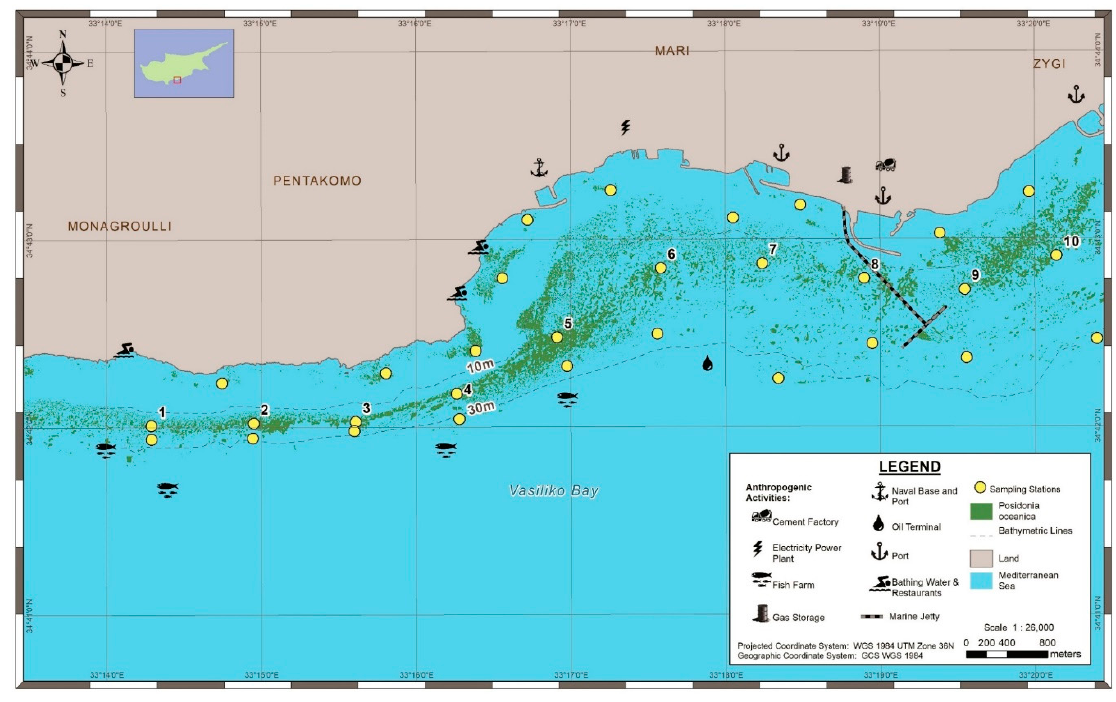
Figure 1. Posidonia oceanica distribution, sampling stations, and anthropogenic pressures across Vasiliko Bay in Cyprus.